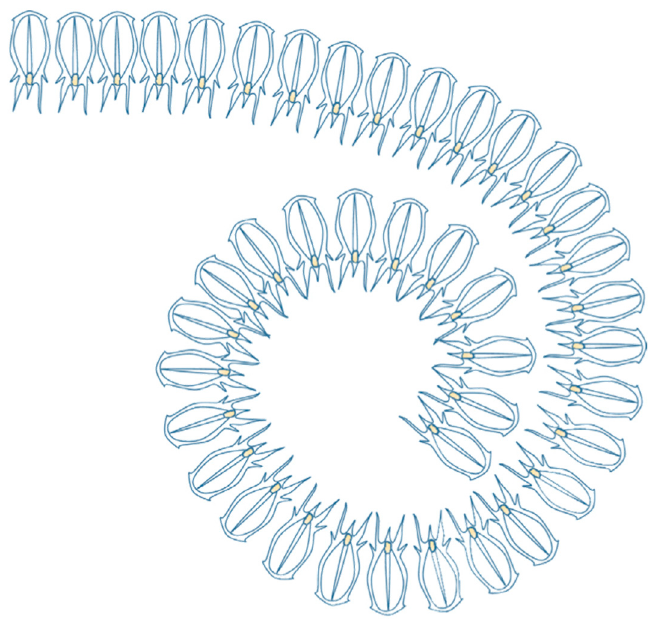
Figure 2. Salp chain illustration with leader and follower concept [28].